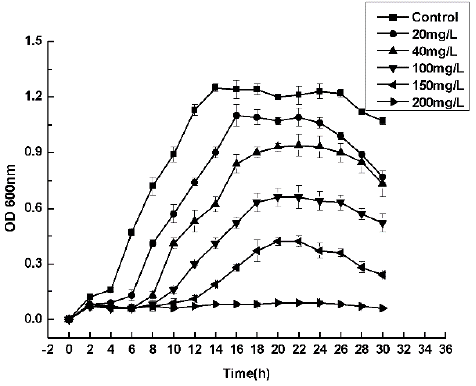
Figure 4. Maximum tolerance concentrations test of P. shigelloides H5. ( p = 0.000).